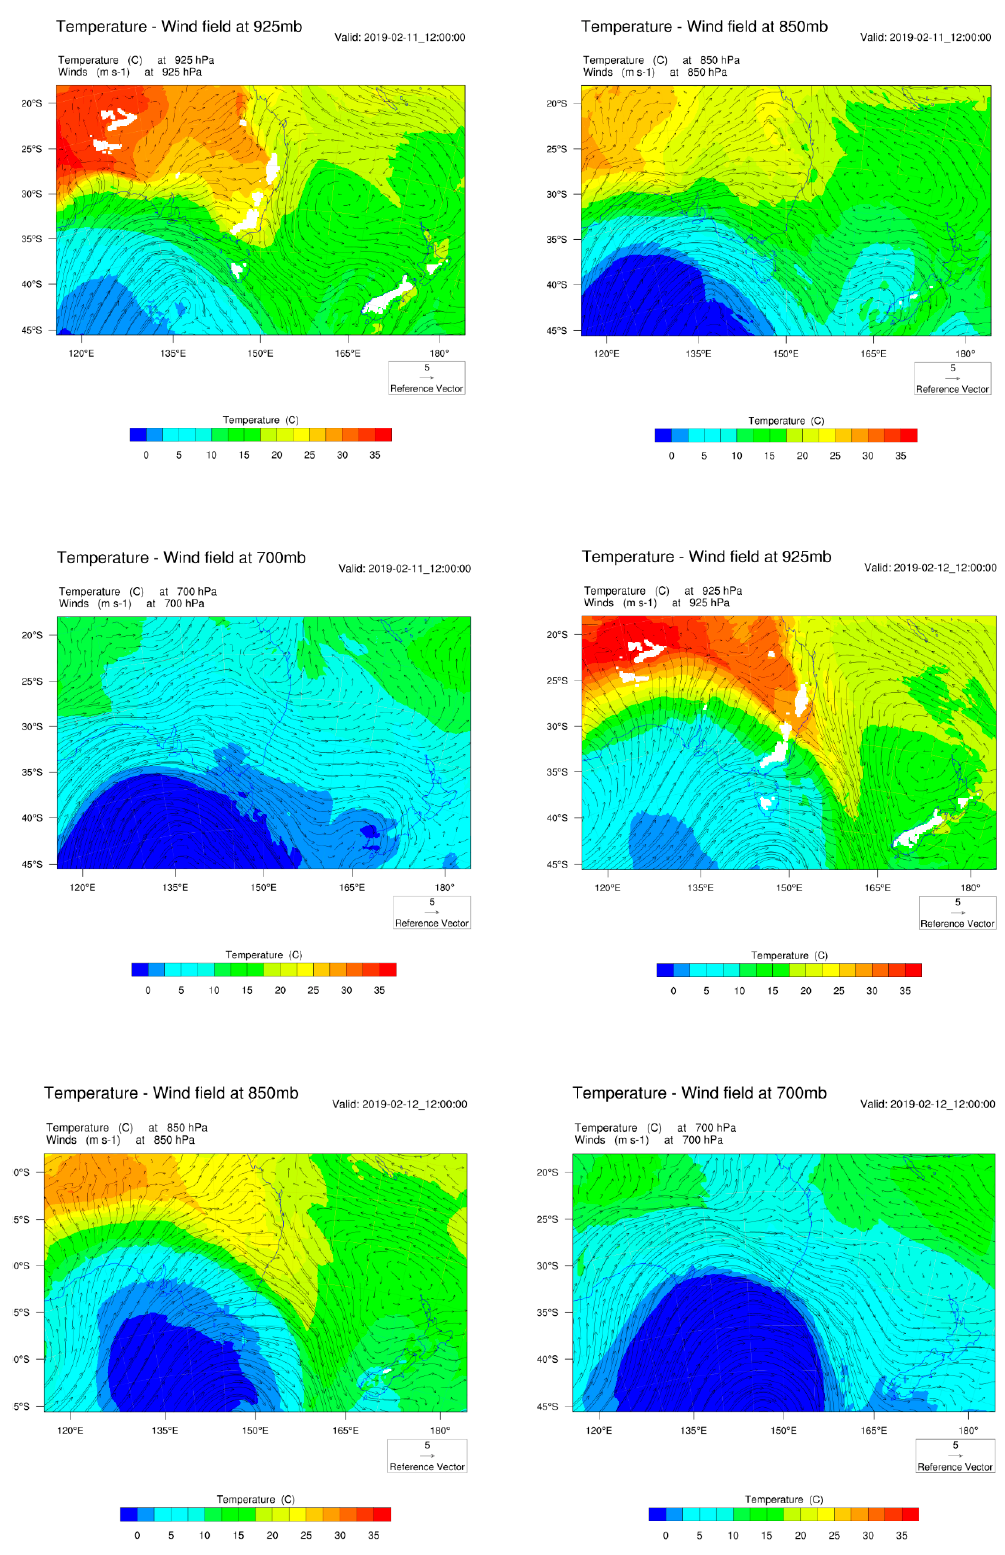
Figure A1. Temperature and wind field at 950 mb, 850 mb and 700 mb on 11 February 2019 12:00 UTC and 12 February 2019 12:00 UTC.